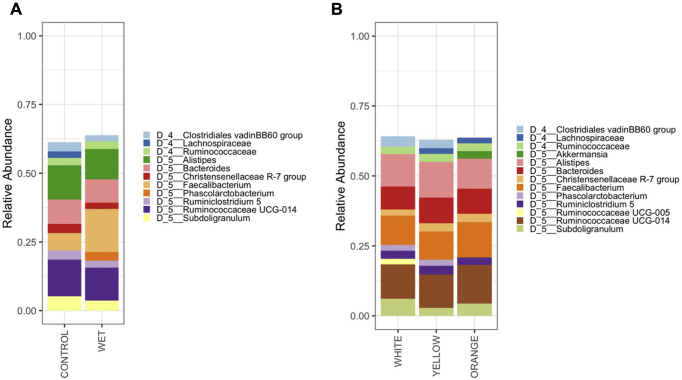
Average relative abundance according to (A) litter treatment or (B) diet of members of the microbiota classified at the genus level. A total of 24 pens were used in this experiment divided evenly between the diet x litter treatment groups. ASV genus taxonomic classifications are proceeded with “D_5.” Classifications beginning with “D_4” indicate ASV classified at the family level but unable to be classified further at the genus level. Abbreviation: ASV, amplicon sequence variant.